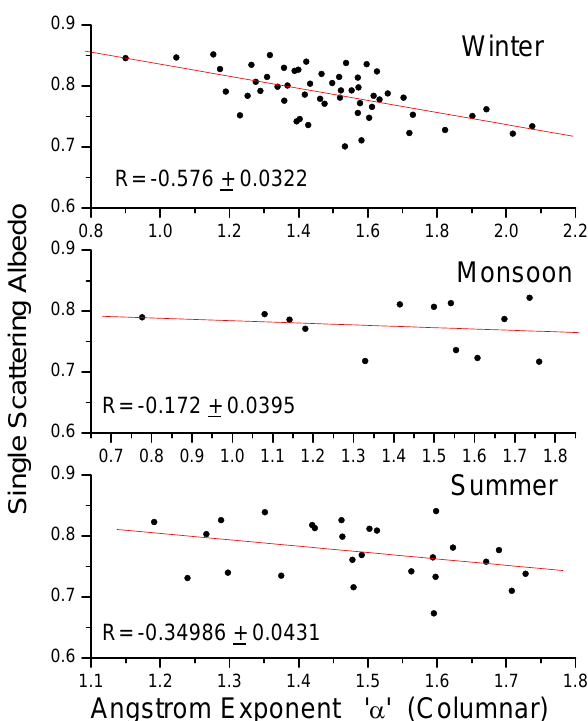
Fig. 7. Scatter plot of SSA (at 550nm) against column Angstrom exponent ( α) during winter, monsoon, and summer months. Num- bers within panels define correlation